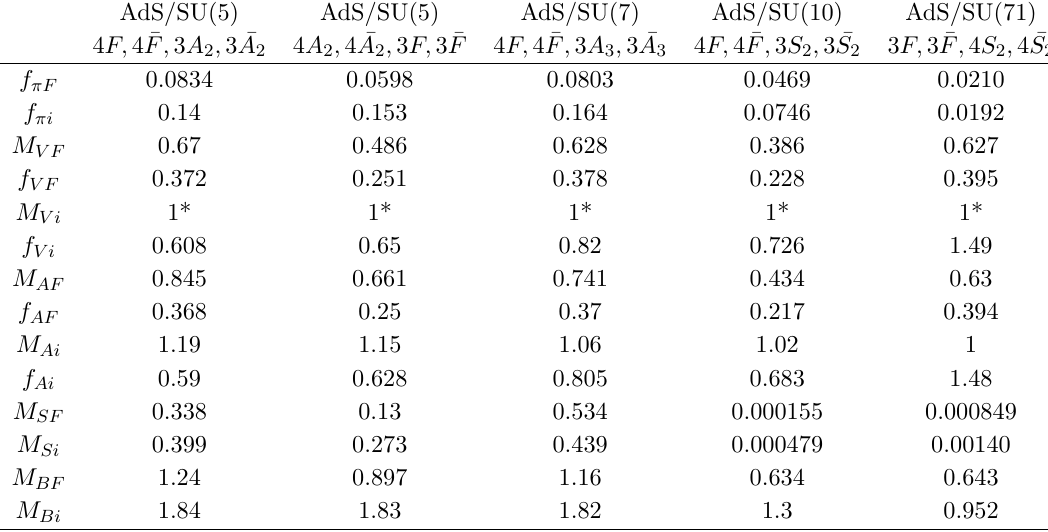
Table 12. Results for gauge theories with matter in four representations. i = A 2 for the first two models. i = A 3 for the next one. For the final two we have i = S 2